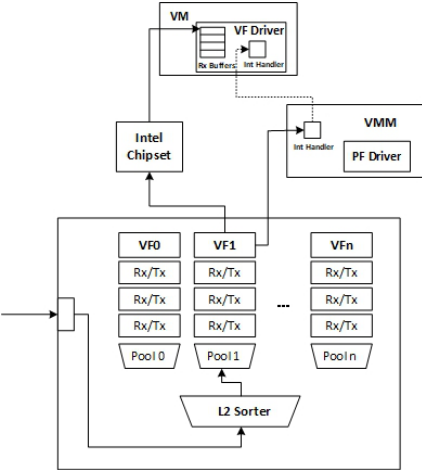
Figure 6. The process of receiving data packets by SR-IOV